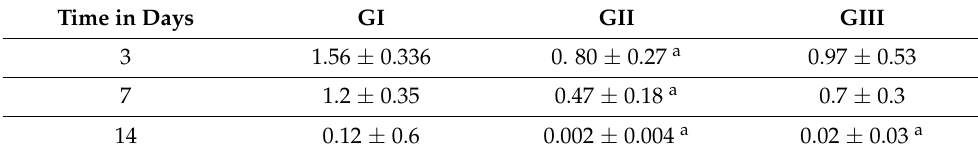
Table 4. Mean ± SD of WSA% in full-thickness skin wounds in control and treated groups. Time in Days GI GII GIII 3 86.7 ± 18.7